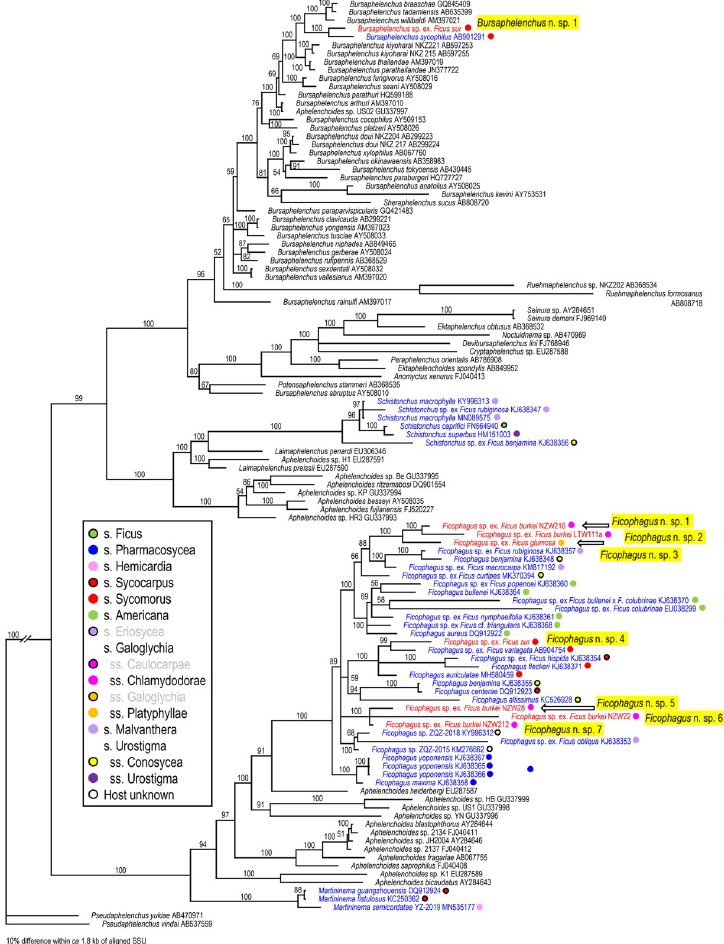
Fig 2. Phylogenetic status of fig-associated species within the family Aphelenchoididae inferred from SSU under GTR + G model. The parameters are: AIC = 56880.841, lnL = -28210.097, freqA = 0.26, freqC = 0.20, freqG = 0.27, freqT = 0.27, R(a) = 0.85, R(b) = 2.47, R(c) = 1.02, R(d) = 0.88, R(e) = 3.48, R(f) = 1.00, Pinva = n/a, Shape = 0.39. Posterior probability values exceeding 50% are given on appropriate clades. Fig-associated nematode species